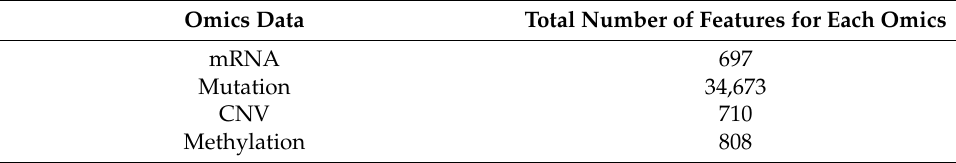
Table 3. Number of features for each omics dataset for 42 cell-line